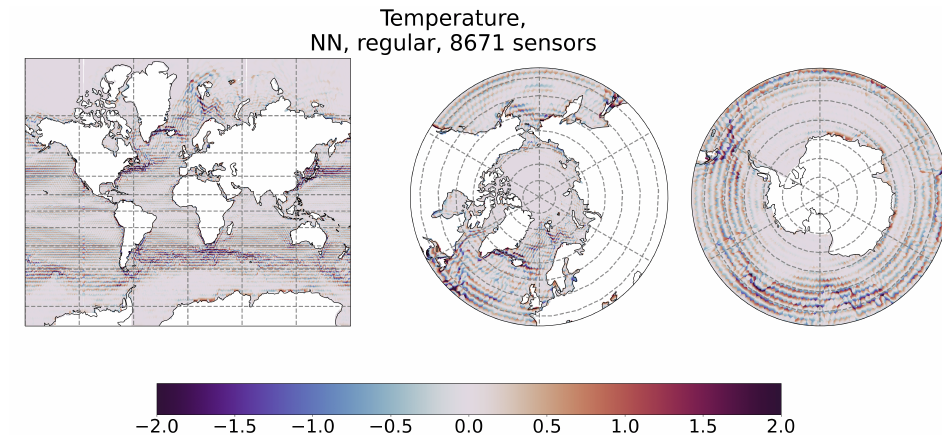
Figure A9. Spatial distribution of reconstruction RMSE by the Nearest Neighbor (NN) method from 1236 measurements with regular placement.